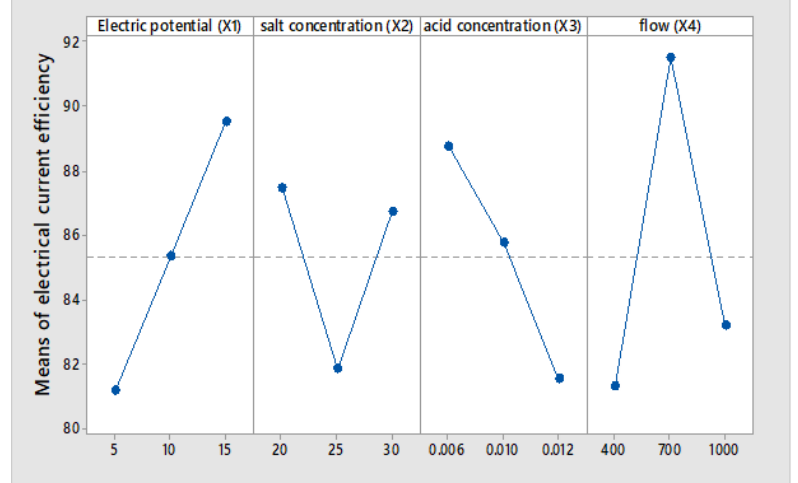
Figure 7. Main Effect Plot for Means of electrical current efficiency.